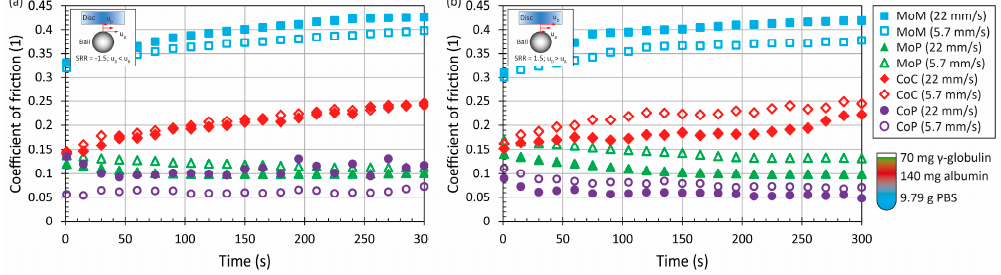
Figure 5. Development of CoF as a function of time for four material combinations at lower and higher mean speed under negative ( a ) and positive ( b ) sliding conditions. Contact is lubricated by model fluid Alb140+Glob70.